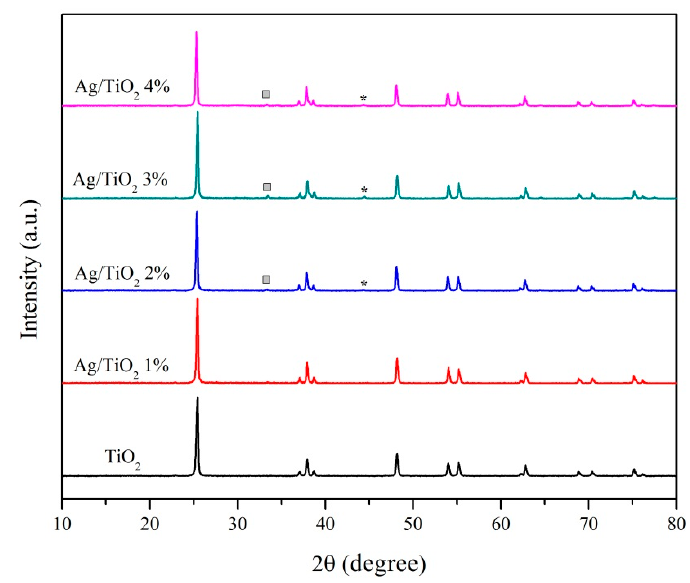
Figure 1. Powder XRD patterns of pristine TiO 2 and Ag/TiO 2 materials. Small squares ( □ ) at 2 θ = 33.2° indicate the presence of Ag I species and the small stars (*) at 2 θ = 44.4° indicate the presence of Ag 0 .